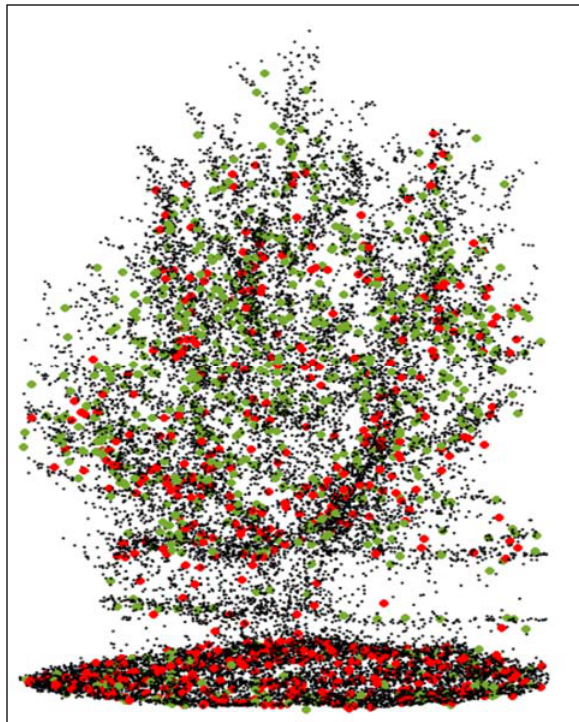
Figure 10. 3d point cloud of shrub object; black: ULS; green: ALB; red: ALS;